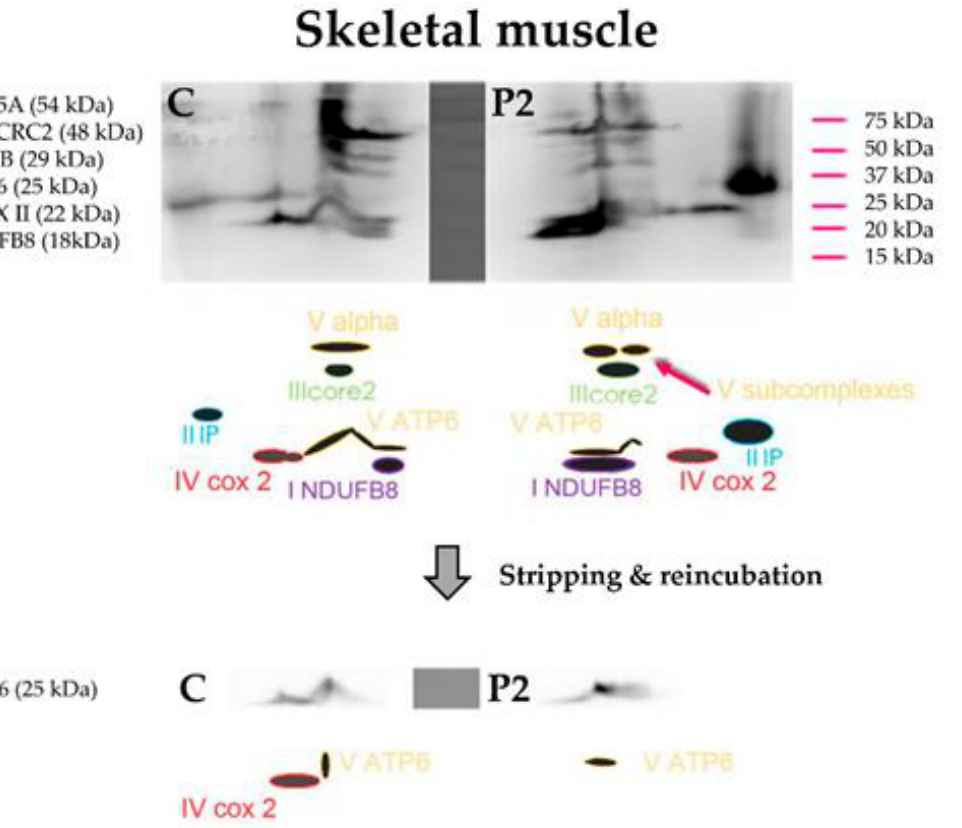
Figure 5. Depicted are the results of the 2D western blot of P2. The results obtained for the isolated mitochondria of cultured skin fibroblasts and skeletal muscle are shown in the upper and middle panel, respectively. In the bottom panel the results after stripping and reincubation with anti-ATP6 are displayed. In each panel the results of a parallelly analyzed tissue specific control sample (C) are included as well.